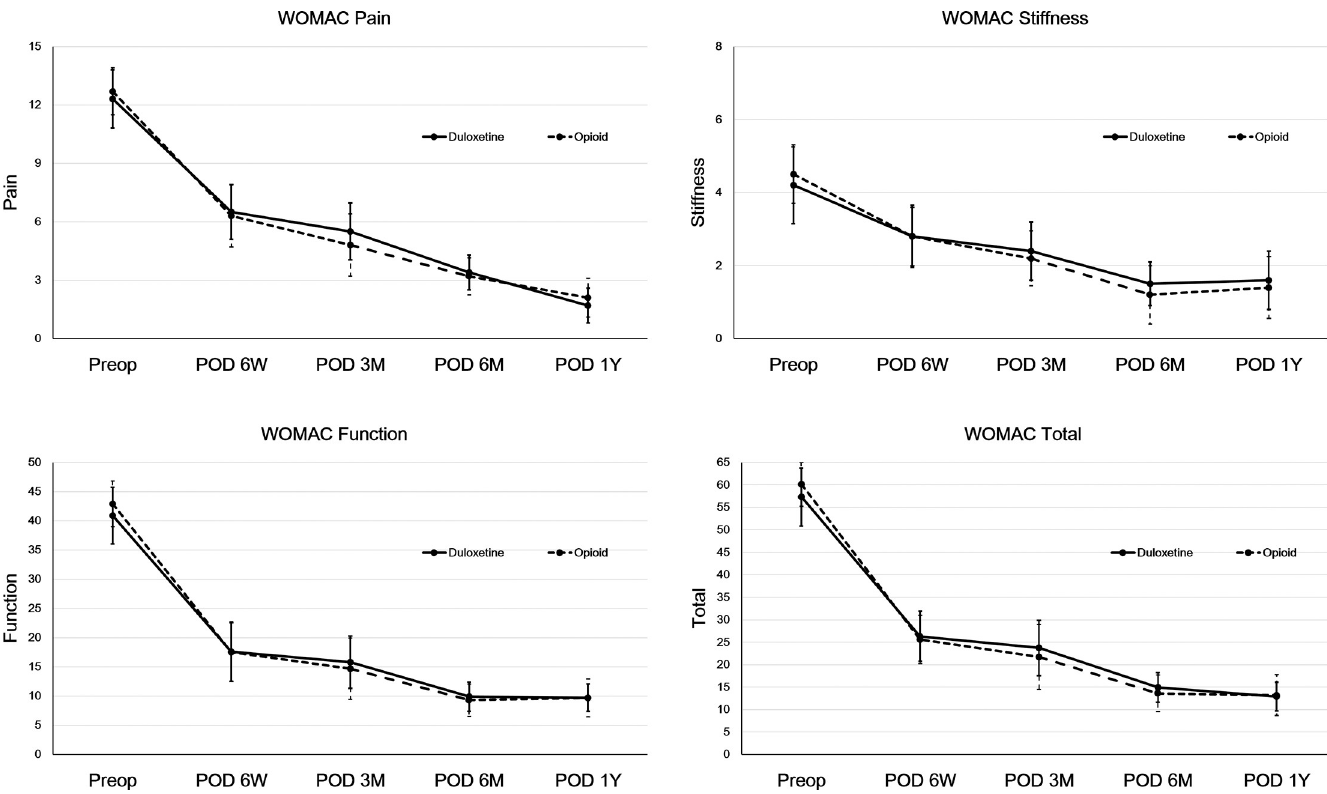
Fig 3. Comparisons of Western Ontario and McMaster Universities OA Index (WOMAC) subscores between duloxetine and opioid groups. There was no difference between the two groups regarding WOMAC pain (A), WOMAC stiffness (B), WOMAC function (C), or WOMAC total (D) at postoperative 6 weeks, 3 months, 6 months, or 1 year. Both groups showed significant improvement of WOMAC pain, stiffness, function, and total score at 1 year postoperatively compared to the preoperative period (all p < 0.05). Error bars represent the standard deviation.